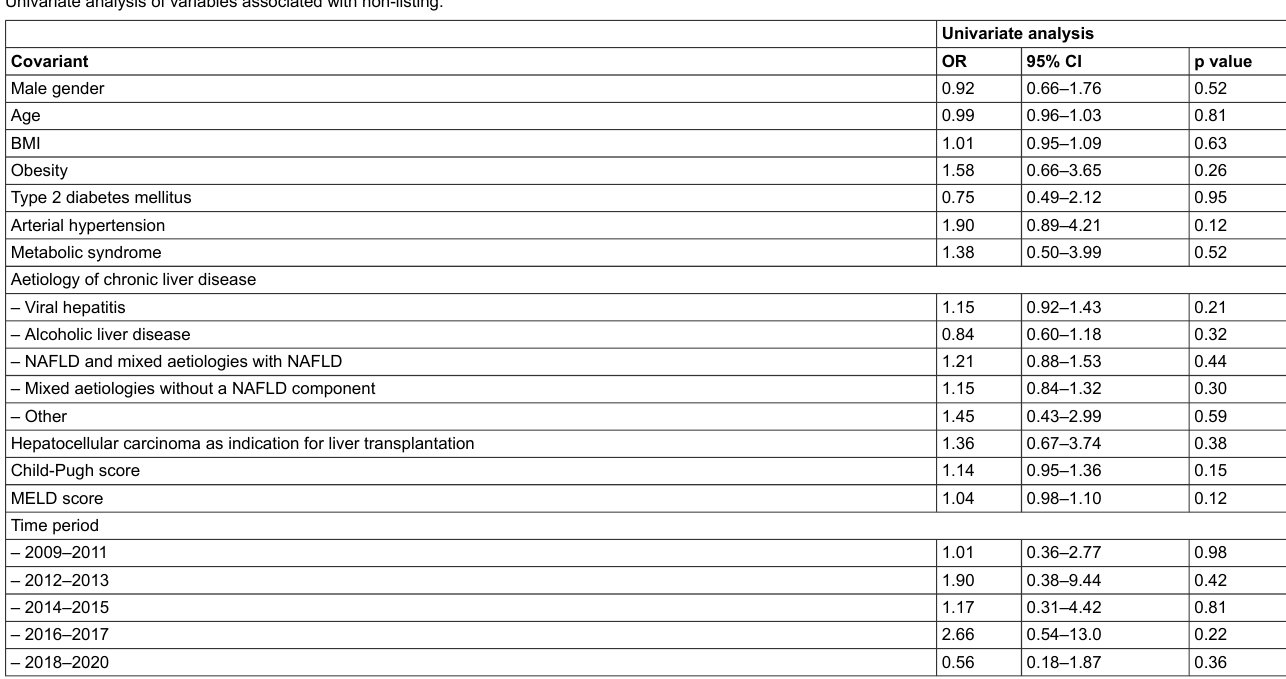
Supplementary table 2: Univariate and multivariate analysis of variables associated with drop-out after placement on waiting list.